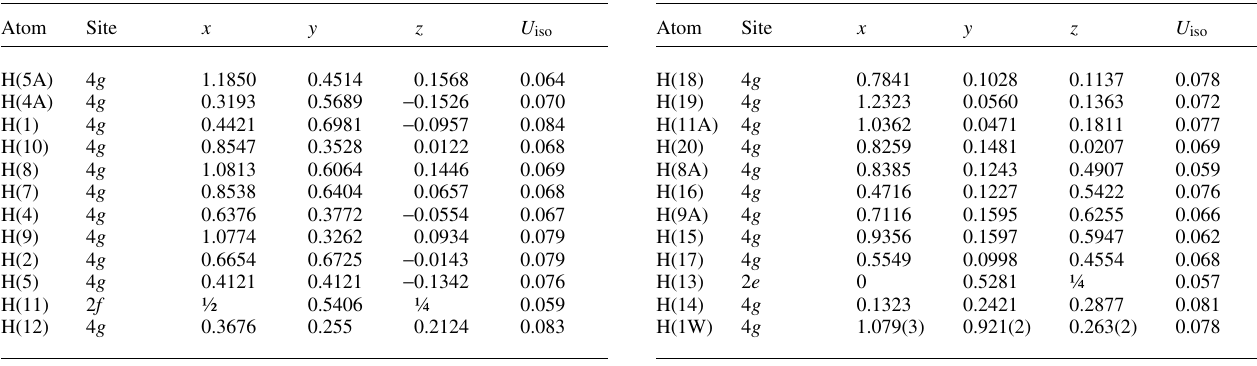
Table 2. Atomic coordinates and displacement parameters (in Å 2 )